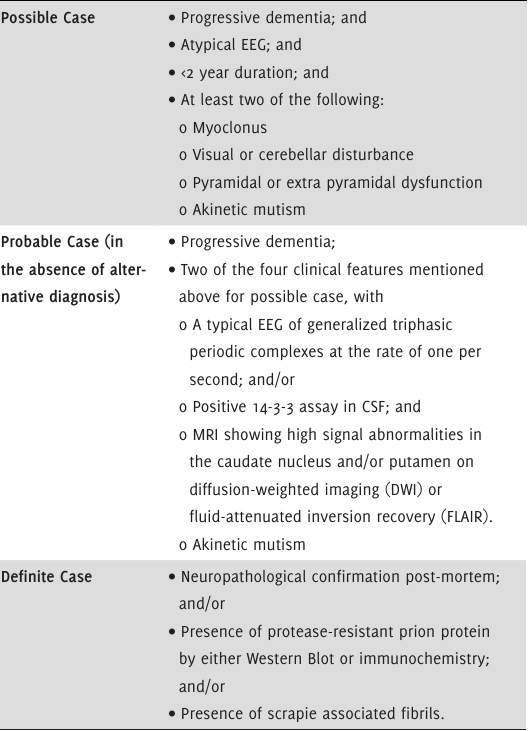
Table 1. Diagnostic Criteria for Sporadic Creutzfeldt-Jakob Disease